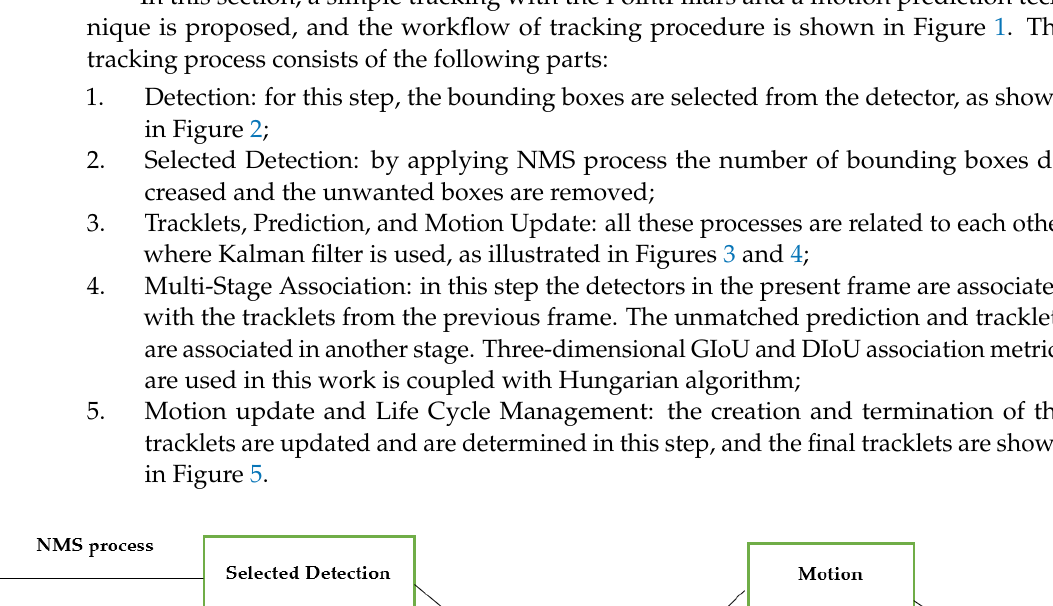
Sensors 2023 , 23 , x FOR PEER REVIEW Figure 1. Three-dimensional MOT workflow steps. Figure 1. Three-dimensional MOT workflow steps.